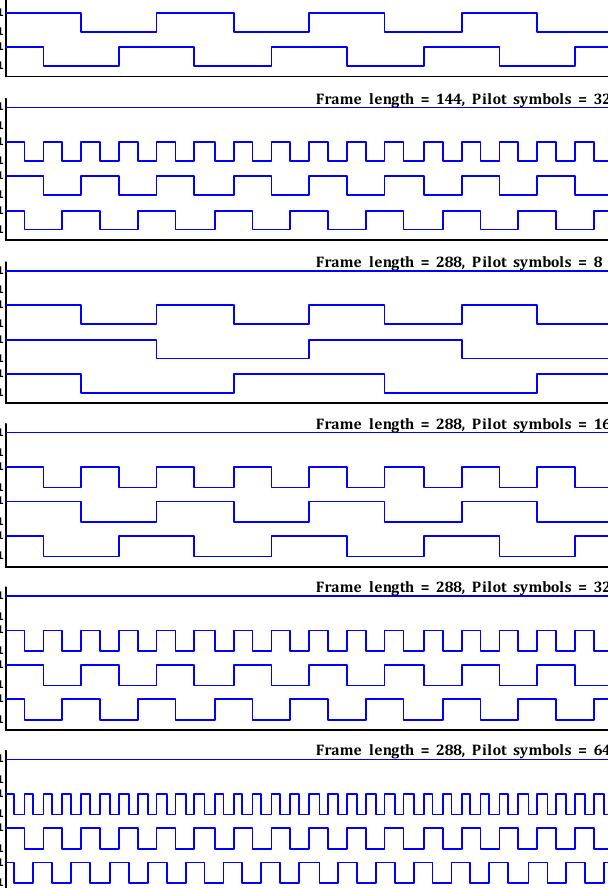
Fig. 1. The four Walsh Hadamard-ordered orthogonal functions (sequences) in a 4×4 MIMO system for the 10 subcases of the frame length and pilot symbols per frame (Table I). The frequency of the third and fourth meanders (differed only by a symbol shift) is half the frequency of the second meander.